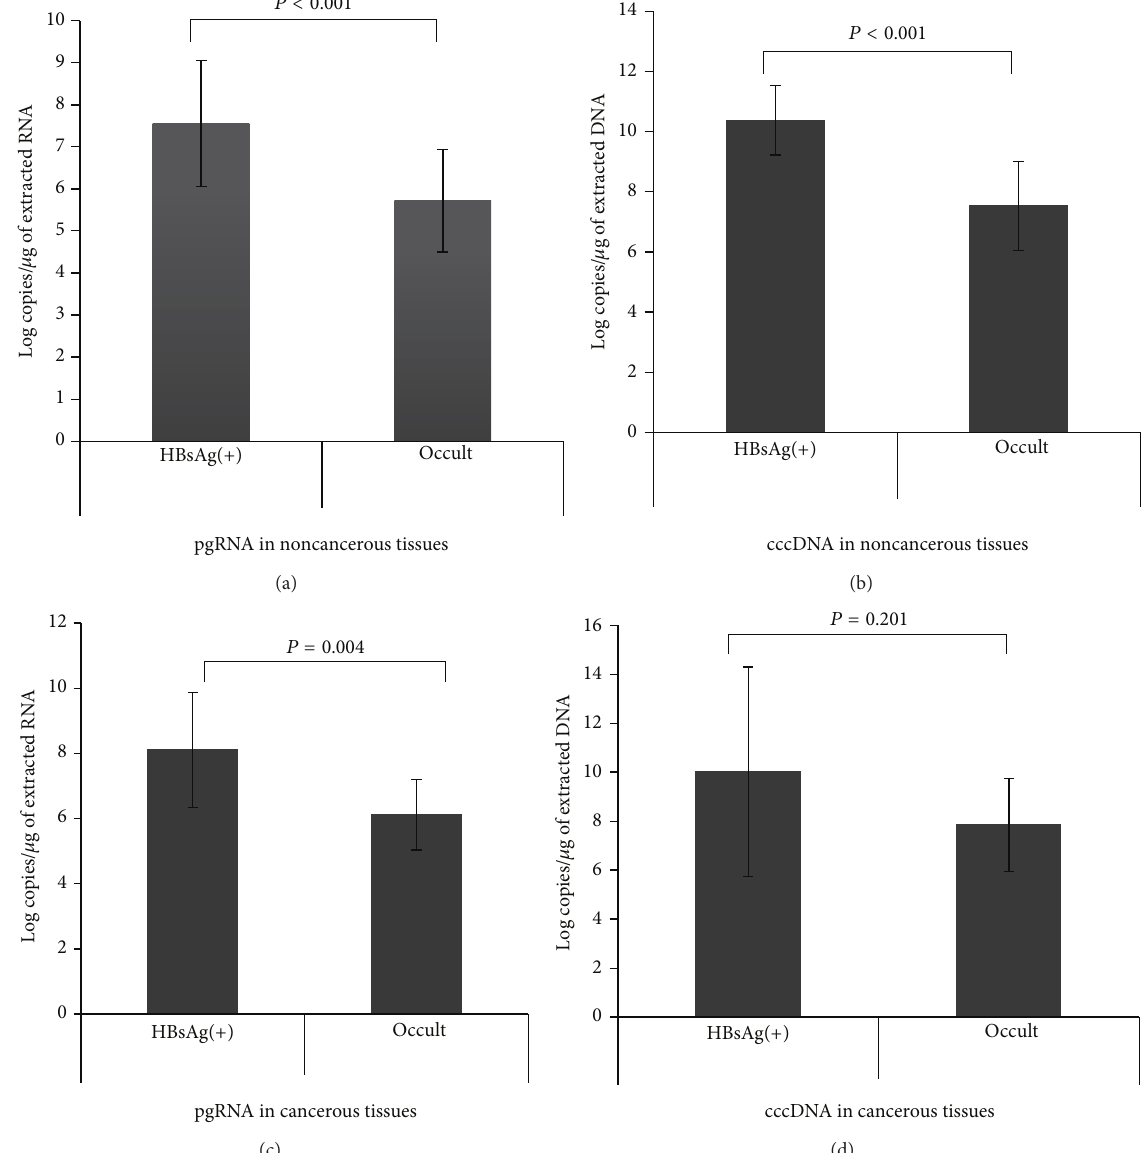
Figure 1: Quantitative analysis of pgRNA (a, c) and cccDNA (b, d) in noncancerous and cancerous liver tissues. The pgRNA and cccDNA expression levels were significantly higher in HBsAg-positive patients than in occult HBV-infected